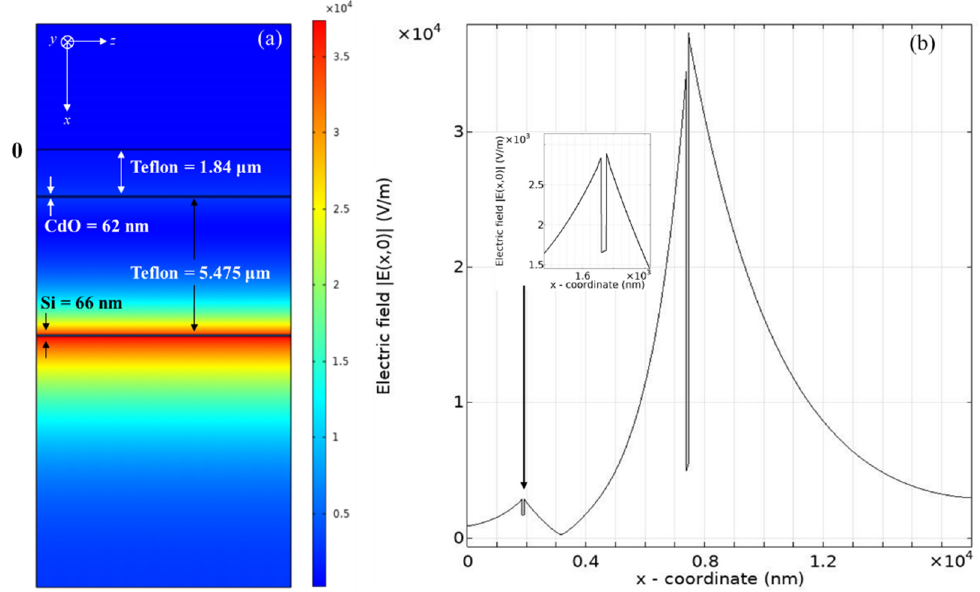
Figure 7. ( a ) Surface electric field and ( b ) the corresponding electric field distribution at the incident angle of 32.4275° in the proposed six ‐ layer hybrid structure.